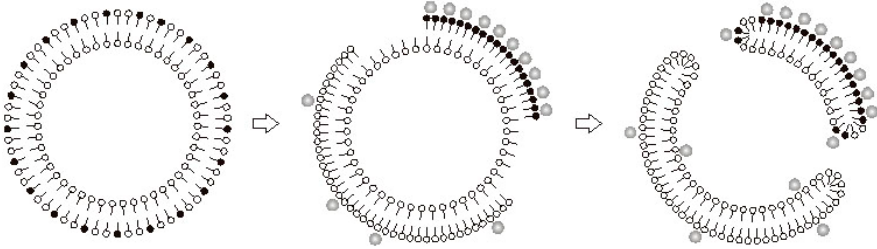
Figure 4. Schematic representation of hydrophilic lipid pore formation in the liposome membrane during a chemotropic phase transition. Adapted from Agafonov et al. J. Membrane Biol. 215 (2007): 57-68. DOI 10.1007/s00232-007-9005-4.